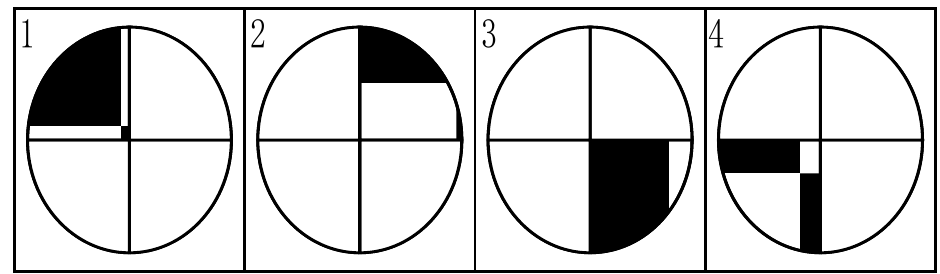
Figure 5. Switching sequences for CT1 configuration.